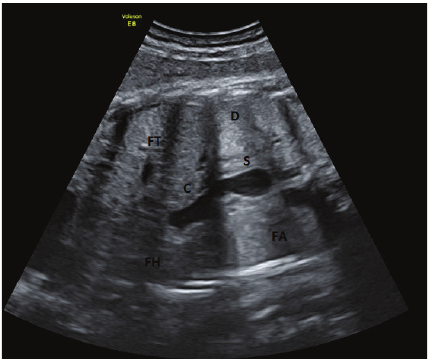
Figure 2: Frontal view: the thoracic cyst (C) is in continuity with a small stomach (S). FH: fetal heart; FA: fetal abdomen; FT: fetal thorax.